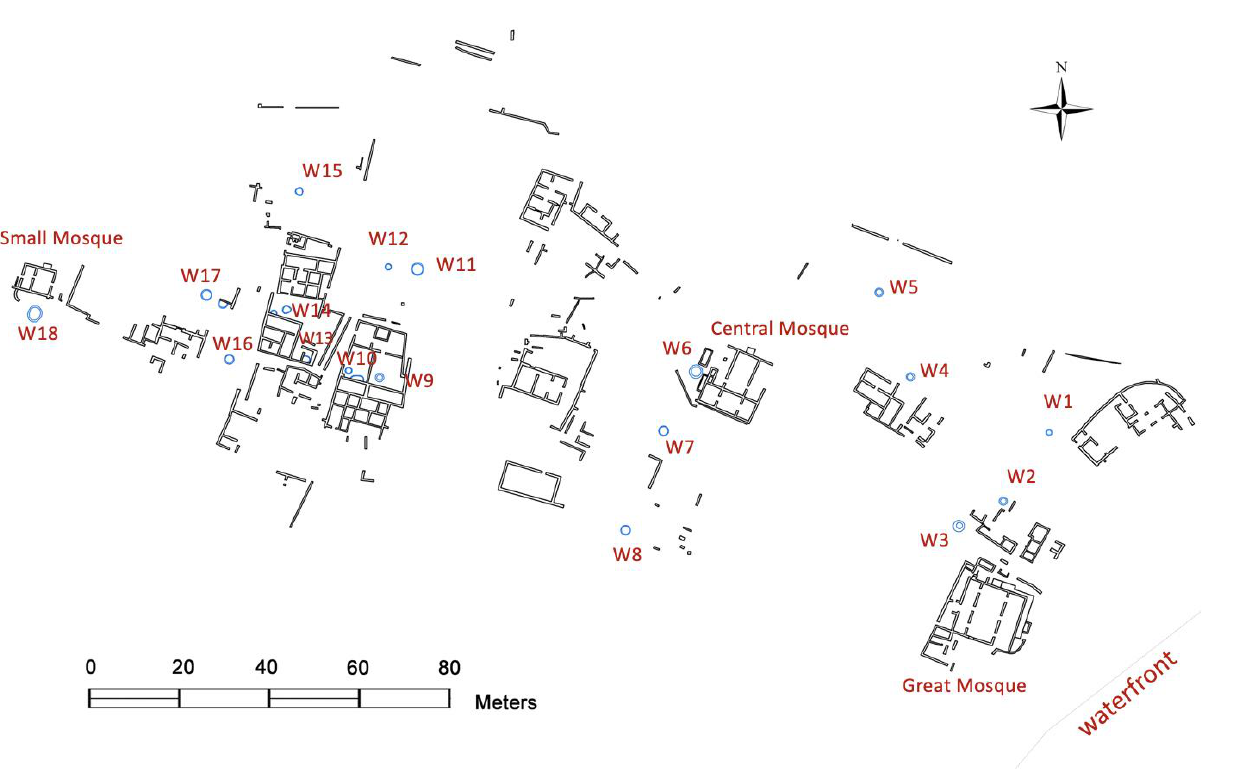
Table 1. The table shows the diameter and placement of all wells identified in the town of Jumba la Mtwana.